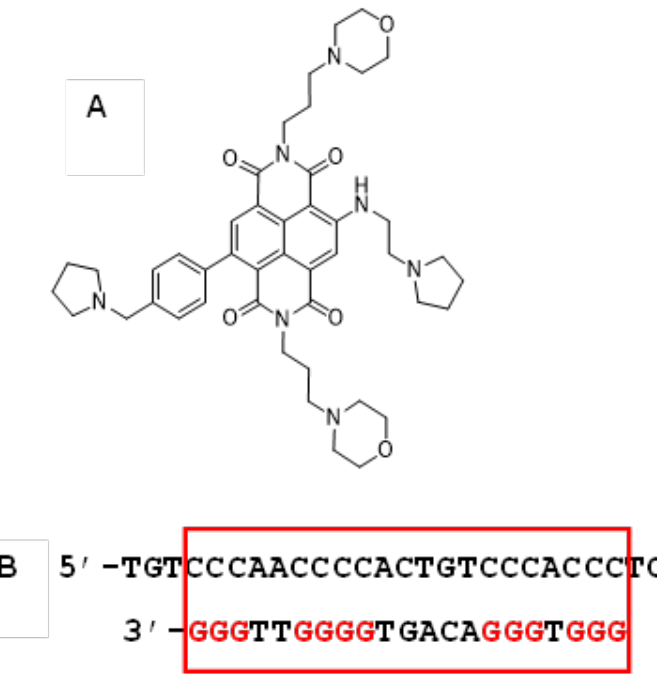
Figure 1. ( A ) Structure of QN-302 (2,7-bis(3-morpholinopropyl)-4-((2-(pyrrolidin-1-yl)ethyl)amino)-9-(4-(pyrrolidin-1-ylmethyl)phenyl)benzo [lmn] [3,8]phenanthroline-1,3,6,8(2H,7H)-tetraone). ( B ) DNA sequence in the promoter region of the S100P gene found to form a G-quadruplex. The G4 sequence itself is bounded within the red box and the individual G-tracts are highlighted in red.